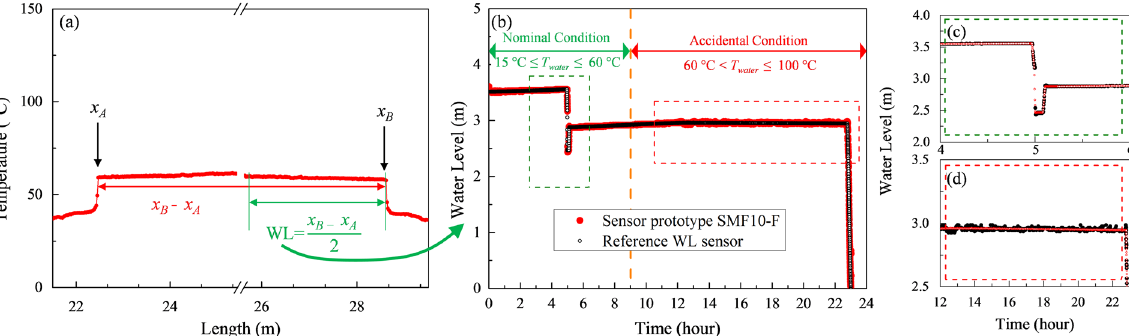
Figure 6. Water level measurement: ( a ) Temperature profile for one of the registered measurements which shows how the WL is calculated from the temperature discontinuities position x A and x B . ( b ) Water level as a function of time measured with the sensor prototype (red dots) and with the calibrated reference sensor (black point) during the entire experiment. ( c , d ) Are zooms in normal and accidental conditions